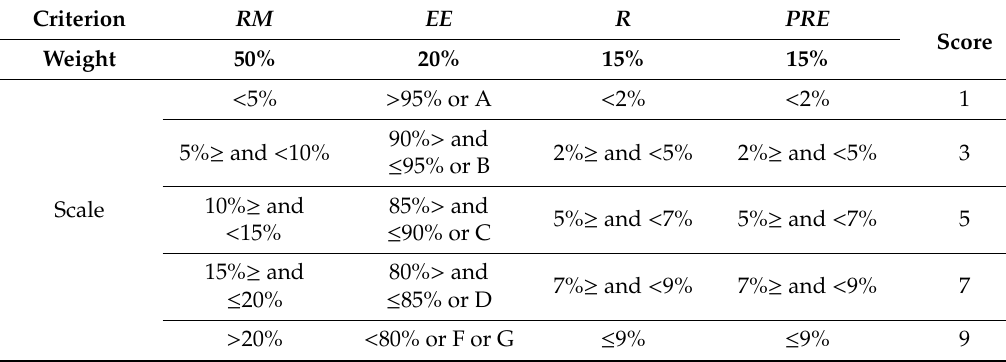
Table 1. RUE : parameters assessment